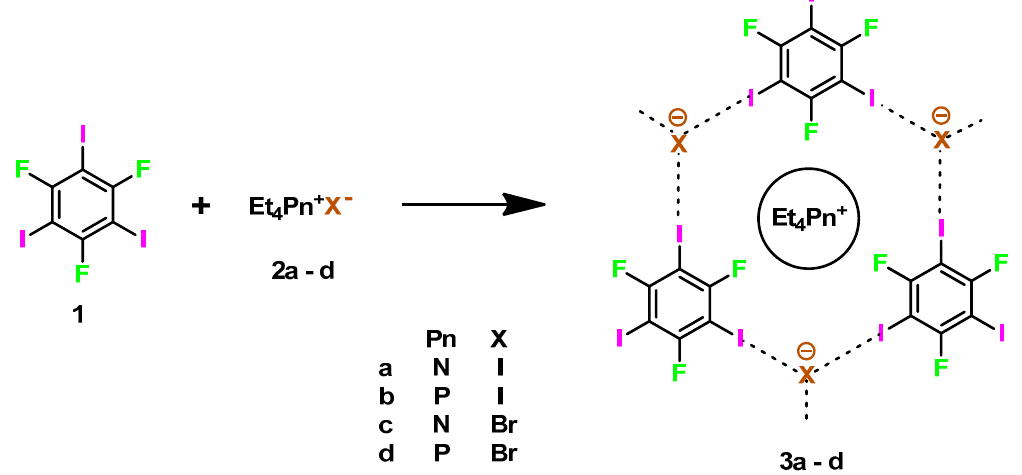
Scheme 1. The formation of the two species (i.e., iodobenzene derivative 1 and salts 2a – d ) and three component (i.e., 1 , the cation, and the anion from salts 2a – d ) co-crystals 3a – d via self-assembly